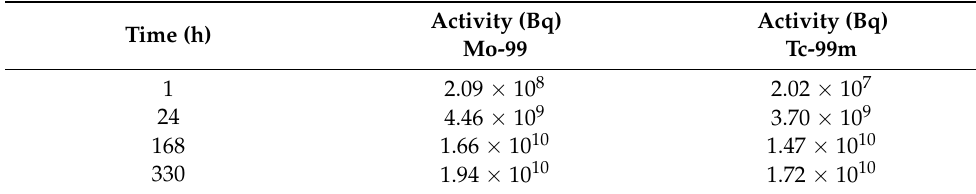
Table 1. Production yield of 99 Mo and 99m Tc using a neutron generator outputting 2 × 10 10 n/s as a function of time. The model assumes complete neutron consumption and transmutation of 98 Mo to 99 Mo within the Mo target and concurrent production of 99m Tc.